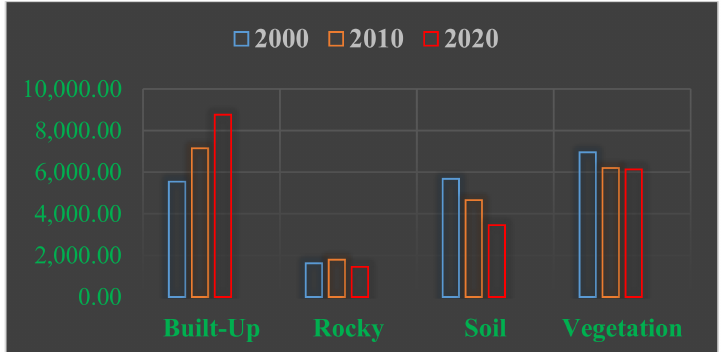
Figure 5. Land cover area (ha) of four classes at three dates provided by MLC.